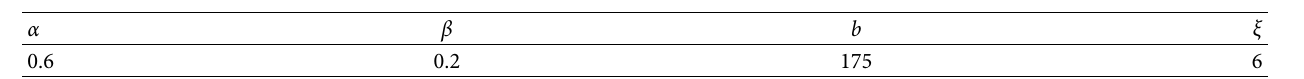
Table 11: Model parameters.